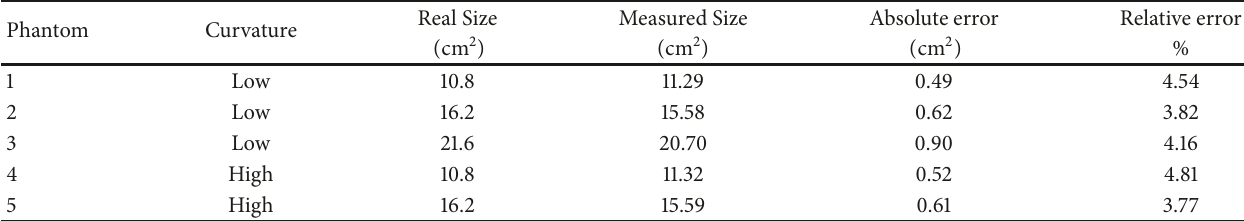
Table 3: Area measurement results from five phantom